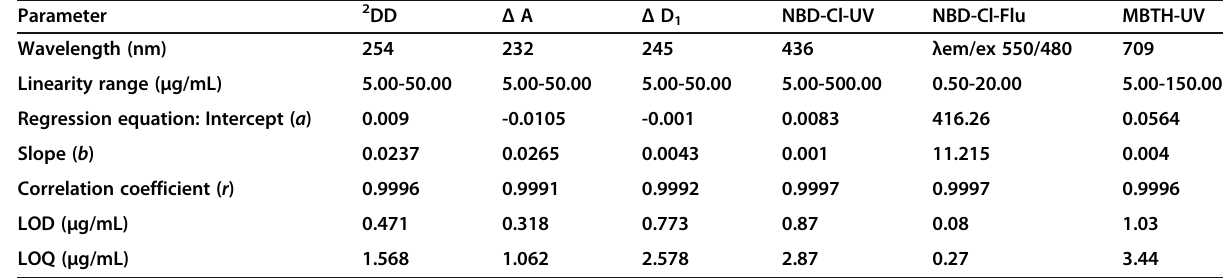
Table 2 Regression equation parameters of the spectrophotometric and spectrofluorimetric proposed methods for the determination of SF and